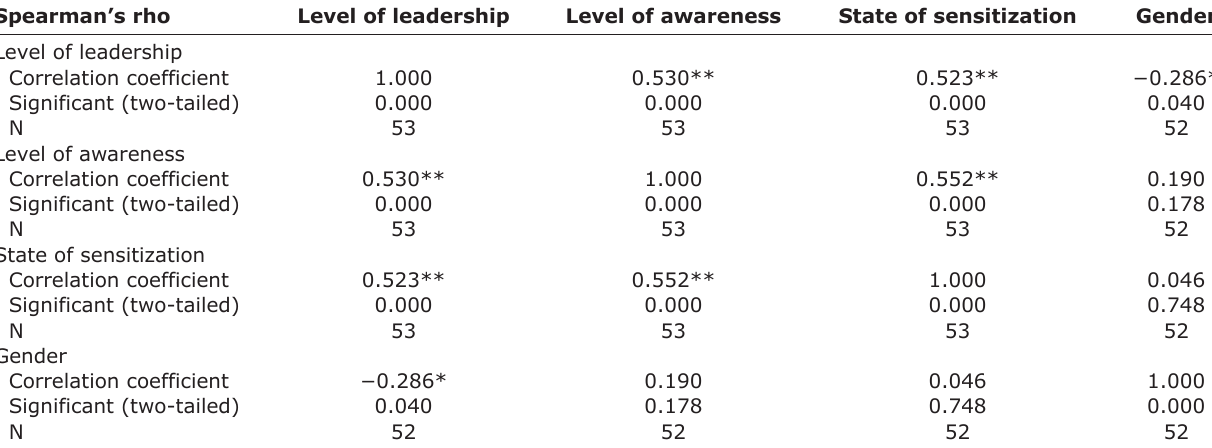
Table-5: Correlations between leadership involvement, awareness, sensitization, and gender in the OH approach. Spearman’s rho